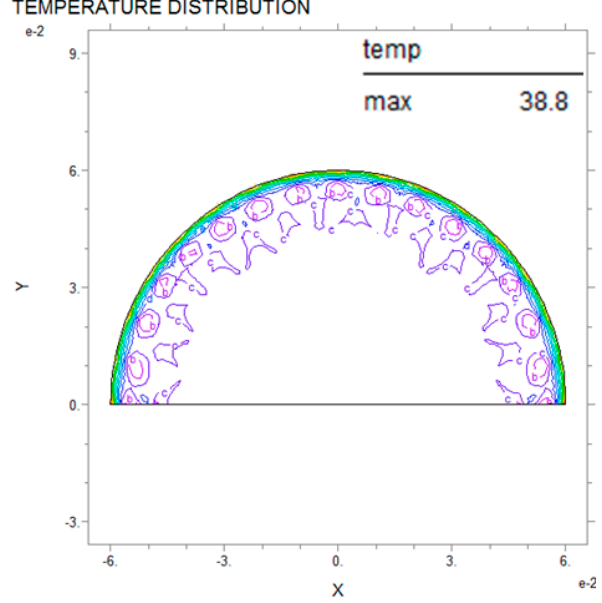
Figure 6. PDE thermal analysis at R1 = 60 mm, R2 = 3 mm.